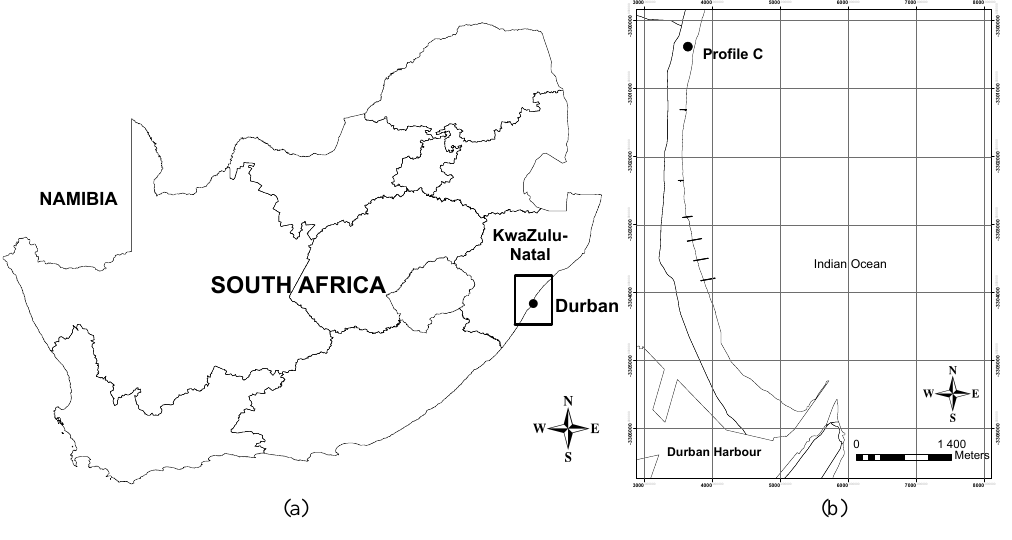
Fig. 1. A map of (a) South Africa showing Durban and a map of (b) the Durban Bight showing the location of profile C and the Durban